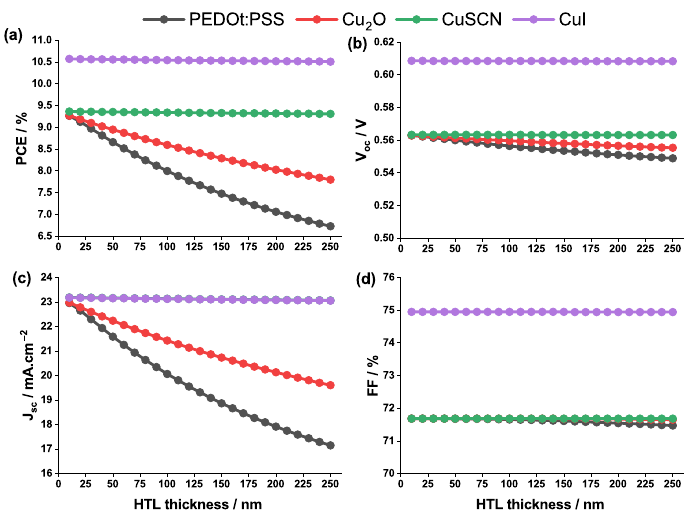
Figure 6. Change in ( a ) PCE, ( b ) V oc , ( c ) J sc , ( d ) and FF against the HTL thickness for different HTL